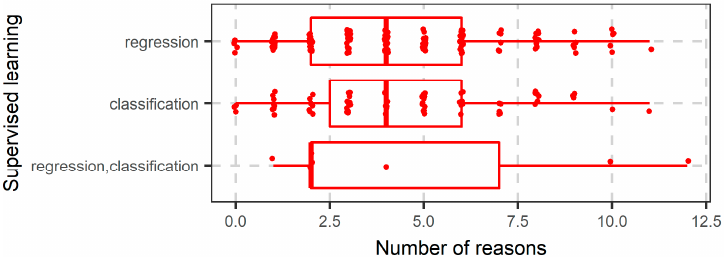
Figure 12. Boxplot of number of reasons per paper for using random forests conditioned on the supervised learning task.